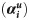
Meta-learning model.(a) Model comparison: model frequencies and exceedance probabilities (XP) of the fitted models based on the AIC. Red lines: 0.5 chance level for model frequency and 0.95 threshold for exceedance probability. meta-VS: meta-learning model where imitation is implemented via VS, and the imitation learning rate is dynamically updated. (b) Average imitation learning rates of the meta-VS model: comparison between imitation learning rates when observing the UD (αiu) and the SD (αis). The purple dots represent the average imitation learning rate of the VS model. ***p<0.001, Wilcoxon test. Underlying data can be found in https://github.com/hrl-team/mfree_imitation/. AIC, Akaike Information Criterion; SD, Skilled Demonstrator; UD, Unskilled Demonstrator; VS, value shaping.